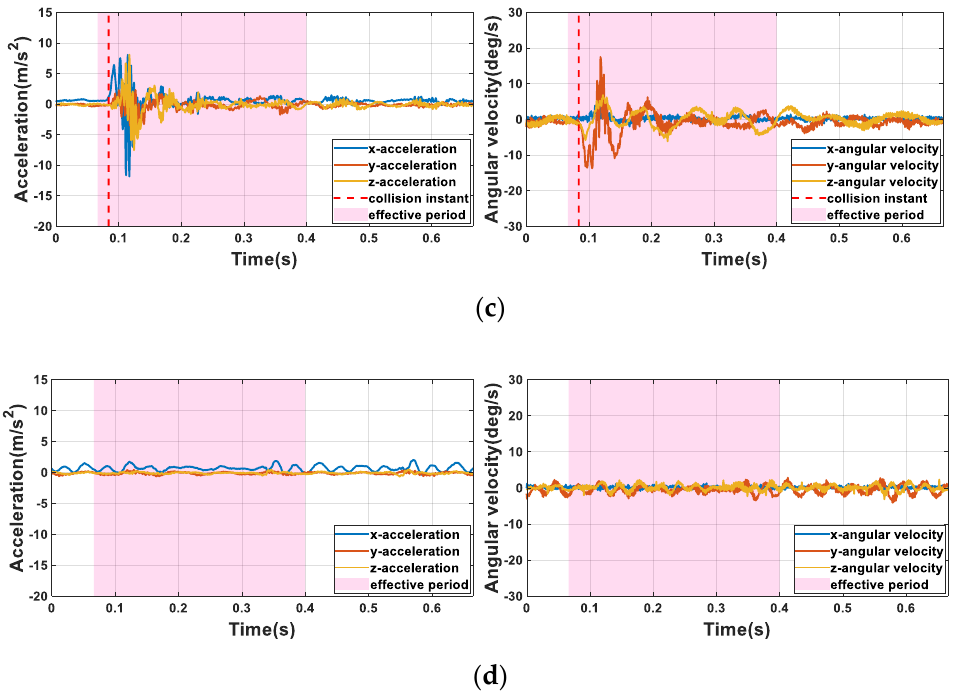
Figure 6. ( a ) The waveform of vulnerable point; ( b ) the waveform of acceptable point; ( c ) the waveform of normal point; ( d ) the waveform of free .